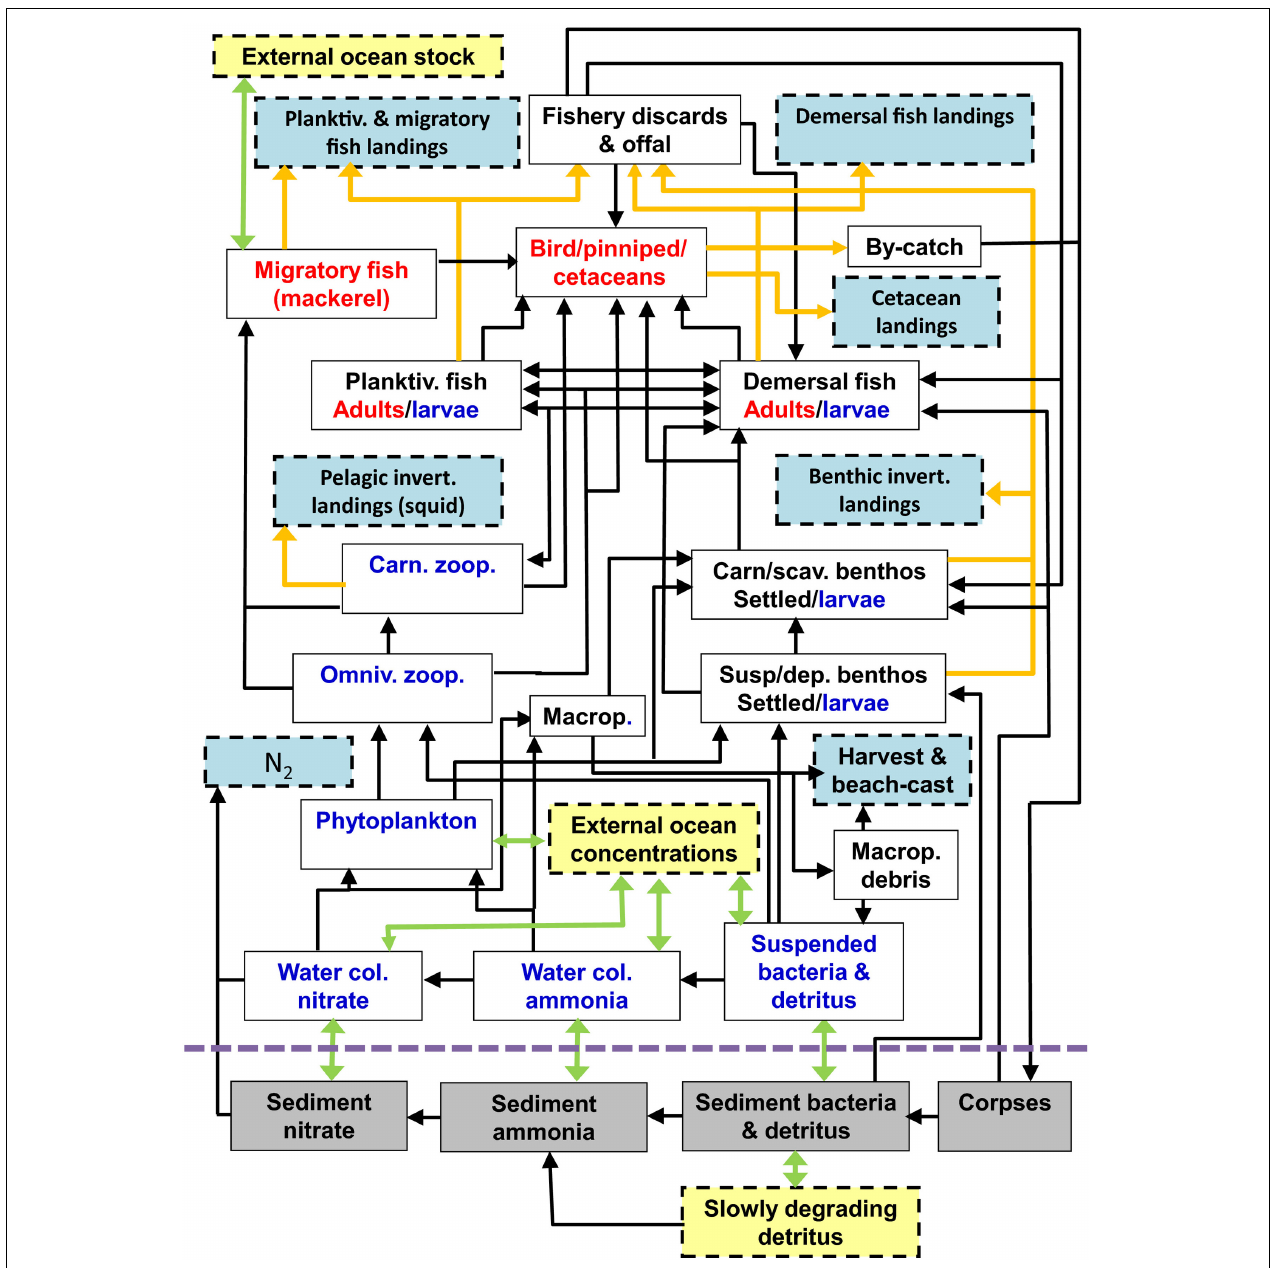
FIGURE 1 | Schematic of the food web compartments of the StrathE2E2 model. Green arrows represent advection, mixing, and migration, orange arrows represent fishery-related fluxes, black arrows represent biological fluxes. Red labelled components are active migrators while blue are subject to passive advection and mixing, and black are anchored. Pale blue boxes represent quantities that are exported from the model while yellow are imported. The model also includes fluxes from living components to ammonia, detritus, and corpses due to excretion, defecation, and death, but these are not shown for clarity. Also for clarity, birds, pinnipeds, and cetaceans are combined as a single box in the figure, but in the model are treated separately. The abbreviation “Macrop” is shorthand for macrophytes. Diagram reproduced from Heath et al.